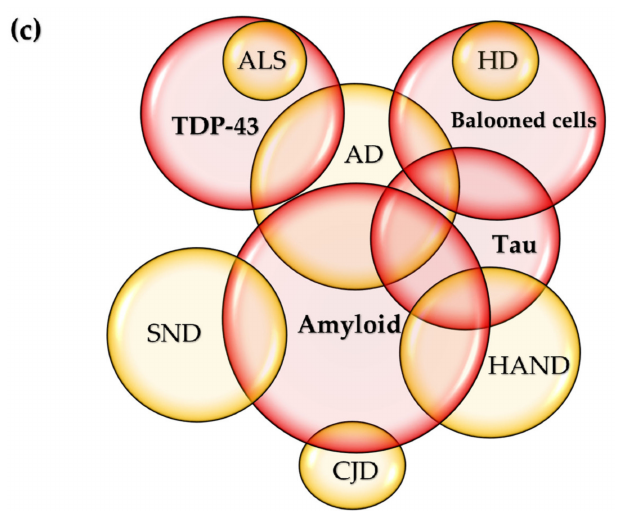
Figure 4. Commonalities of neurodegenerative diseases. ( a ) In total, 30% of patients with Alzheimer’s disease (AD) develop parkinsonism, whereas over 30% of patients with Parkinson’s disease (PD) present dementia during their disease course. ( b ) Lewy body (LB) disorders include PD, PD with dementia, and dementia with LBs (DLB). DLB and PD with dementia share AD-type pathology and about 50% of PD with dementia is considered progression of the underling comorbidity with AD. ( c ) The amyloid deposits in the neurons and glial cells are characteristic to AD, and tauopathy is most prevalent in AD. The tauopathy of AD is considered secondary to the deposition of amyloid- β (A β ). Pathognomonic to amyotrophic lateral sclerosis (ALS), TDP-43 proteinopathy is detected in up to 50% of patients with AD. The ballooned nerve cells abundant in Huntington’s disease (HD) are found in tauopathy such as in AD. Amyloid deposition is also observed in about 10% of Creutzfeldt–Jakob disease (CJD), starting with AD-like cognitive symptoms, and rapidly progressing to dementia and death. Di ff use intracellular amyloid plaques are associated with age and HIV-associated neurocognitive disorders (HAND). Increased hyperphosphorylated tau was reported in HIV-infected patients on combination antiretroviral therapies (cART). Stroke-induced secondary neurodegeneration (SND) shares many similarities to AD such as abnormal amyloid